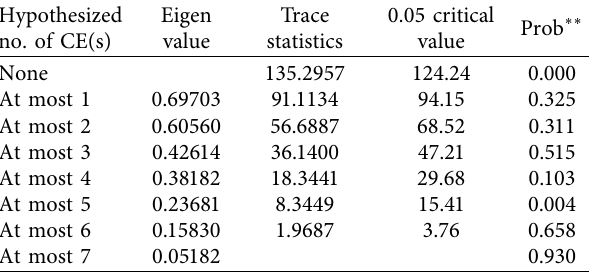
Table 5: Cointegration test result.